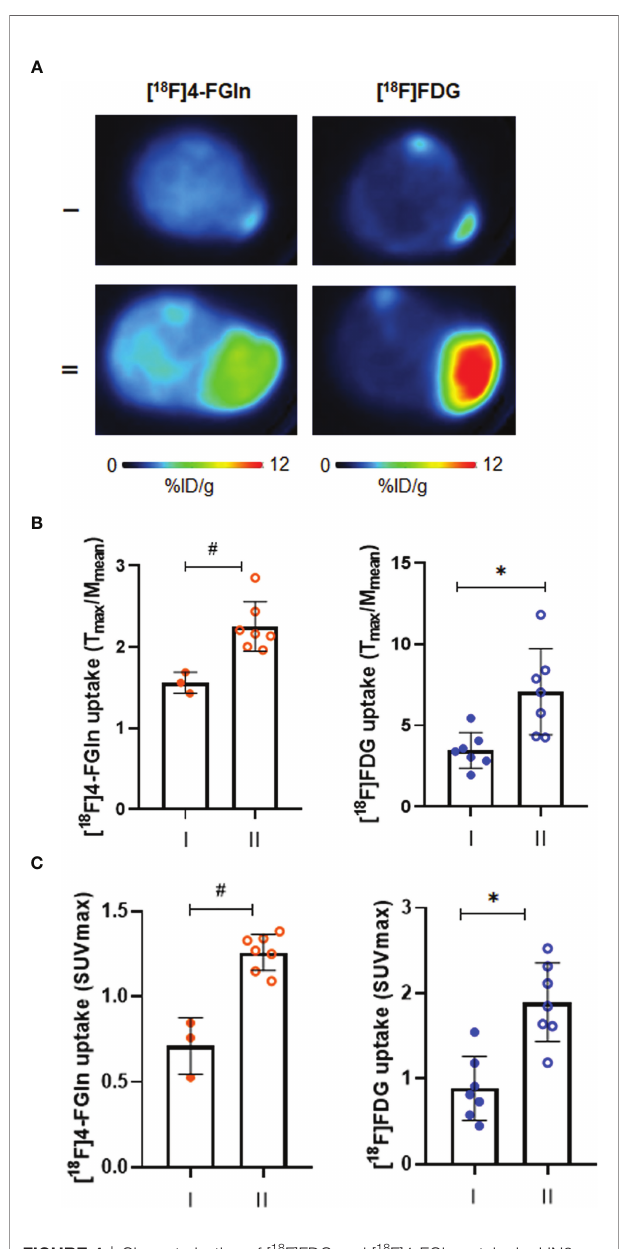
FIGURE 4 | Characterization of [ 18 F]FDG and [ 18 F]4-FGln uptake in JJN3 tumor model. (A) Transaxial [ 18 F]FDG and [ 18 F]4-FGln PET images of a representative JJN3 tumor-bearing mouse acquired on days 5 – 6 (I) and 12 – 13 (II) expressed as %ID/g. (B) Quantitative analysis of radiotracers uptake expressed as T/M. Differences intra- and intergroups were tested for signi fi cance using Wilcoxon matched-pairs signed rank-test and Unpaired Mann-Whitney test. *p = 0.0156; # p = 0.0167. (C) Quantitative analysis of radiotracers uptake expressed as SUVmax. Differences intra- and intergroups were tested for signi fi cance using Wilcoxon matched-pairs signed rank-test and Unpaired Mann-Whitney test. *p = 0.0156; # p =